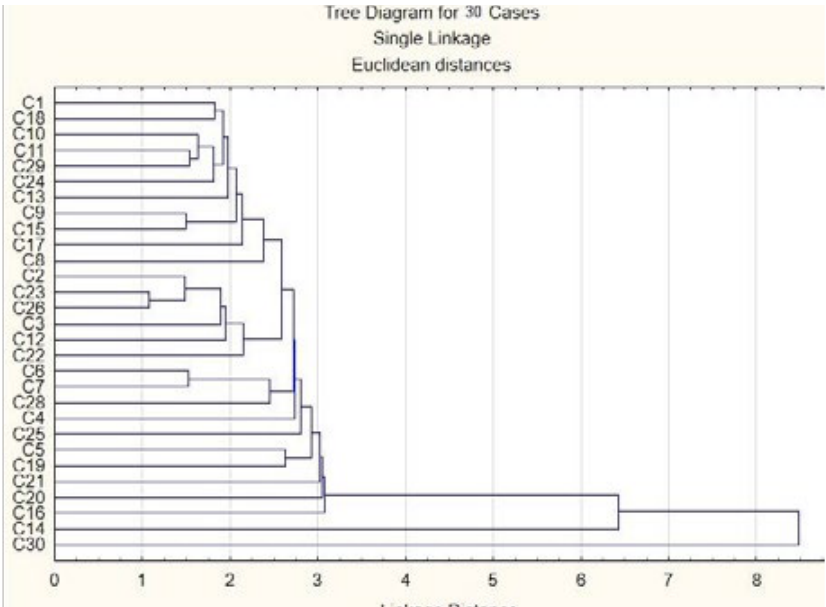
Fig. 4: Integral indicator of resistance and prevalence rates of COVID-19 of the united territorial communities of Sumy region